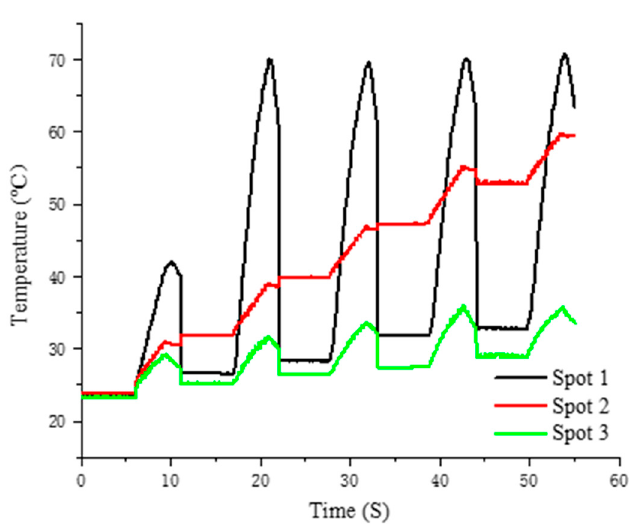
Figure 6. Observation points for temperature during EST.